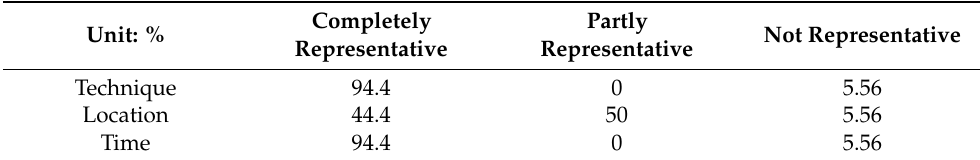
Table 3. Data quality assessment of the silver separation